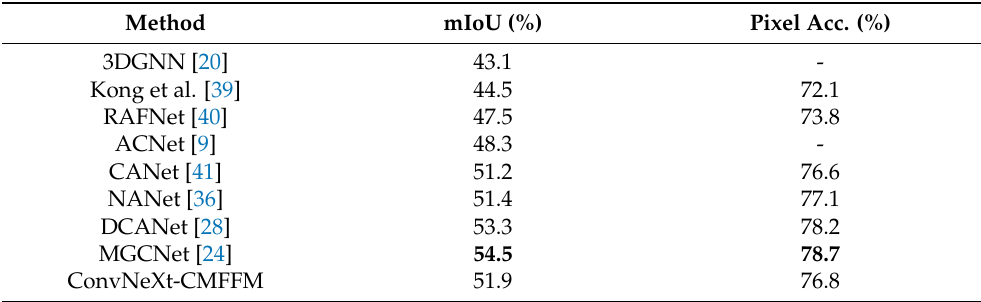
Table 2. Comparison with the state-of-the-art models on the NYUDv2 dataset (the top ones are marked in bold).